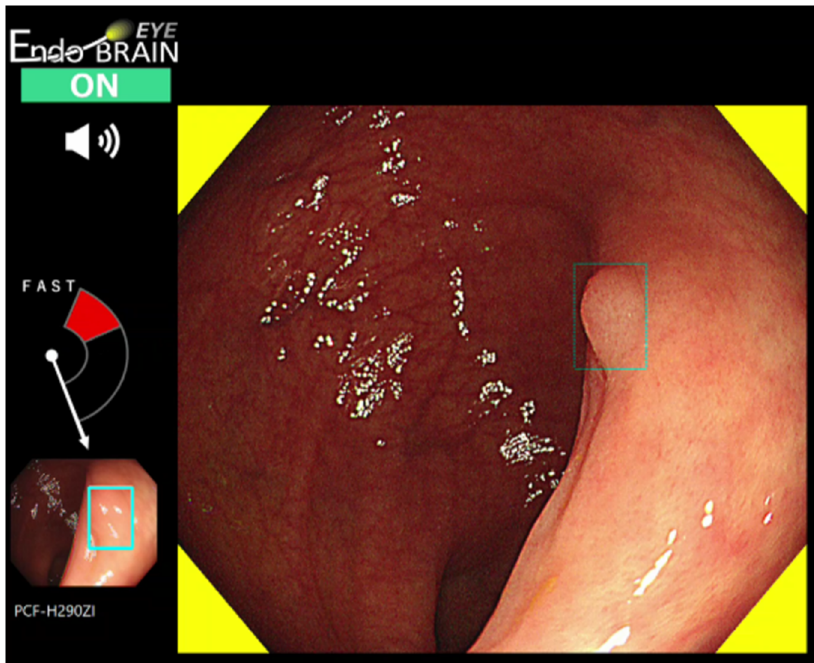
Figure 1. EndoBRAIN-EYE output screen showing the detection of a colorectal polyp. Color and sound alert the user to the detection of a polyp. The location of the polyp is indicated by a rectangle displayed on the screen.